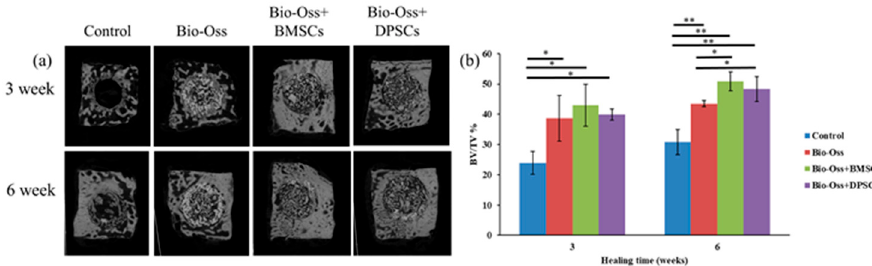
Figure 7. ( a ) Micro-CT images of defect regions in control, Bio-Oss, Bio-Oss + BMSC, and Bio-Oss + DPSC groups at 3 and 6 weeks. Comparison of BV/TV values among the four experimental groups at ( b ) 3 and ( c ) 6 weeks after surgery. The results show significant differences in the bone formation among the various groups (* p < 0.05, ** p < 0.01).